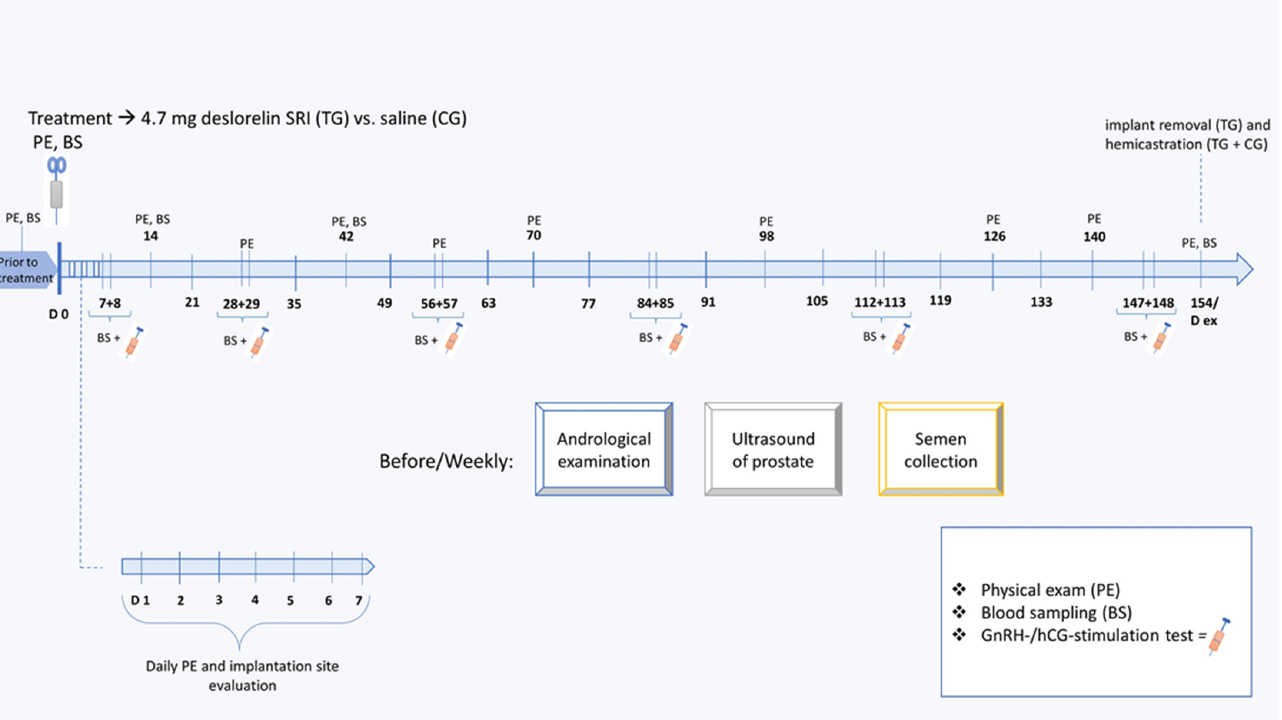
Figure 1. Detailed experimental design. The study includes two groups: TG animals (n = 7) were treated with a 4.7 mg deslorelin slow-release implant (SRI) into the paraumbilical area where CG animals (n = 3) were subcutaneously treated with 0.5 mL saline into the umbilical area.